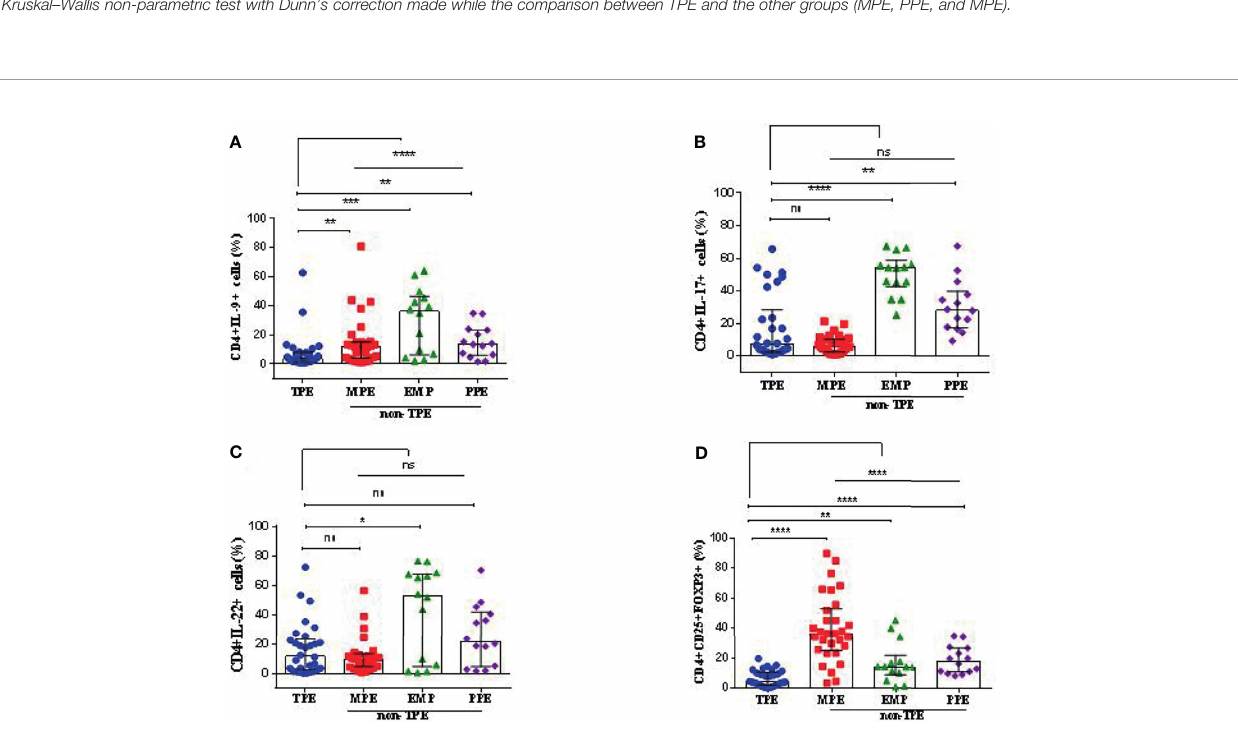
FIGURE 3 | Graphical analysis of T-cell subset frequencies in pleural effusions. (A) The frequency of CD4+IL-9+ cells in TPE (n = 30), MPE (n = 30), EMP (n = 14), and PPE (n = 14). (B) The frequency of CD4+IL-17+ cells in TPE (n = 30), MPE (n = 30), EMP (n = 14), and PPE (n = 14). (C) The frequency of CD4+IL-22+ cells in TPE (n = 30), MPE (n = 30), EMP (n = 14), and PPE (n = 14). (D) The frequency of CD4+CD25+FOXP3+ cells (Treg cells) in TPE (n = 30), MPE (n = 30), EMP (n = 14), and PPE (n = 14). TPE, tuberculous pleural effusion; MPE, malignant pleural effusion; PPE, parapneumonic pleural effusion; EMP, empyema. All values are presented as the median and 5% – 95% percentile and comparisons made between TPE, and the other groups were performed using the Mann – Whitney U test. *p < 0.05, **p < 0.01, ***p < 0.001, ****p < 0.0001. ns, non signi fi cant.